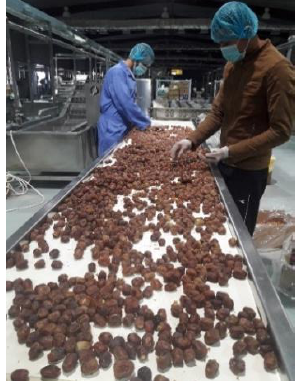
Figure 2. Dates grading quality